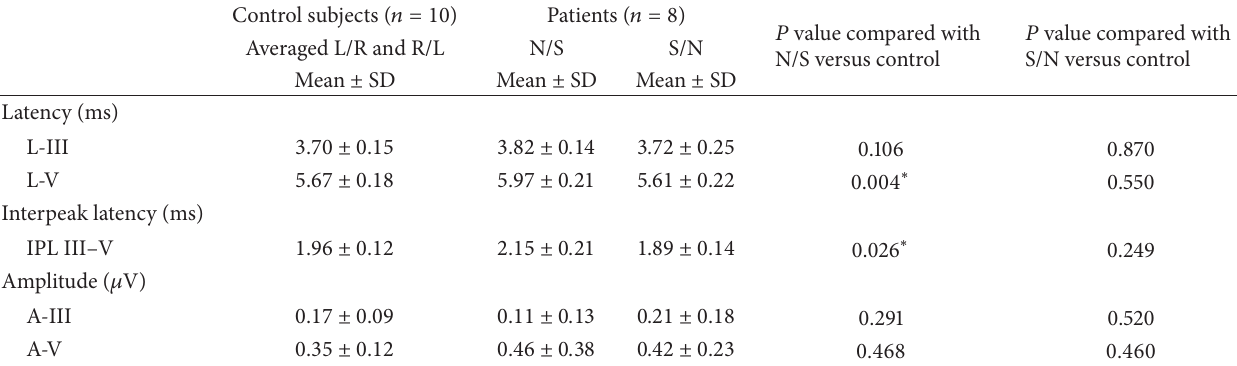
Table 5: Contralateral-side comparisons between patients and control